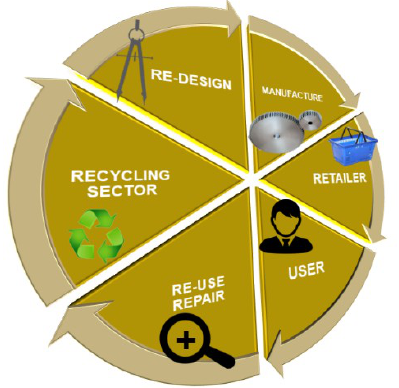
Figure 8. Circular economy and industrial symbiosis aim to create a more sustainable and resource-efficient way of supplying CF-based products to the